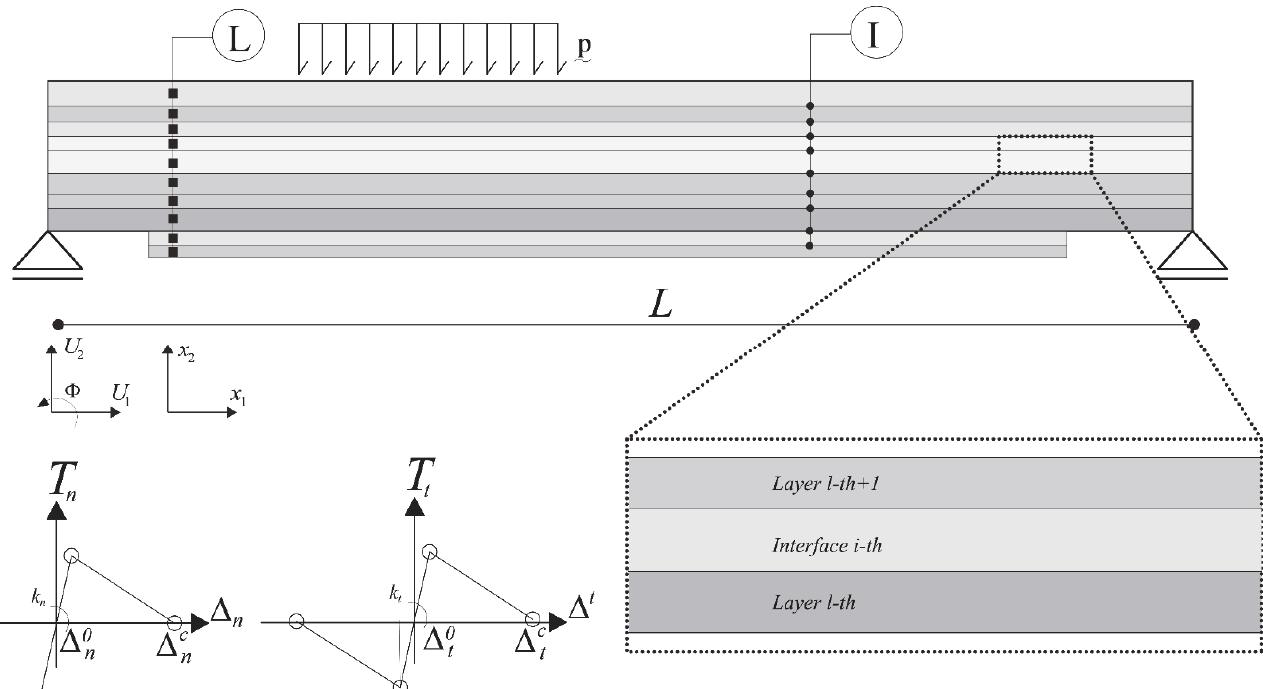
Figure 1: Layered structure: geometry, interfaces and